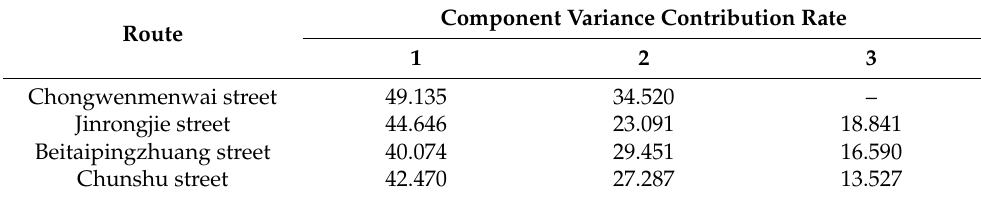
Table 5. The variance contribution rate of each street route component. Route